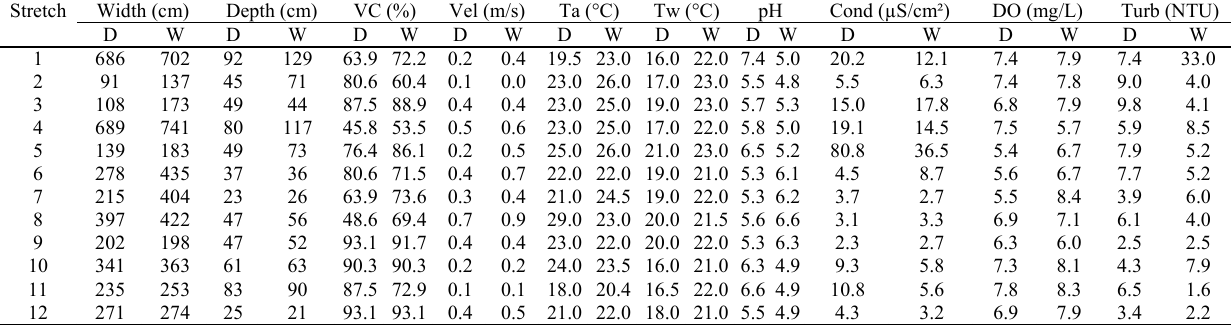
Table 4. Environmental variables sampled in the streams of the APA Gama and Cabeça de Veado during dry (D) and wet (W) seasons. Width, depth, vegetation cover (VC), water velocity (Vel), air temperature (Ta), water temperature (Tw), pH, water conductivity (Cond), dissolved oxygen (DO), and turbidity (Turb).